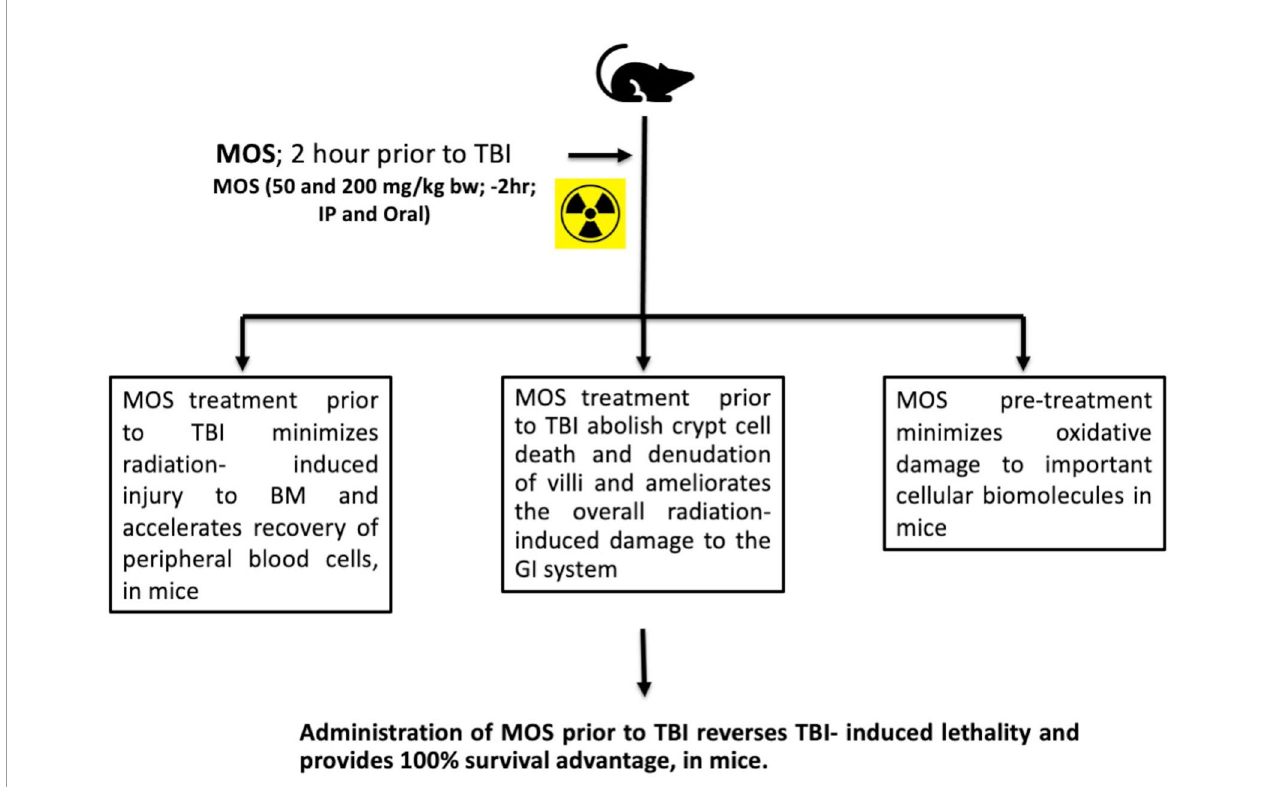
FIGURE 10 | MOS mediated radiation protection in vivo : Under in vivo condition, MOS pretreatment abates radiation-induced damage to hematopoietic system and gastrointestinal system, accelerates recovery, and consequently abrogates TBI-induced lethality in